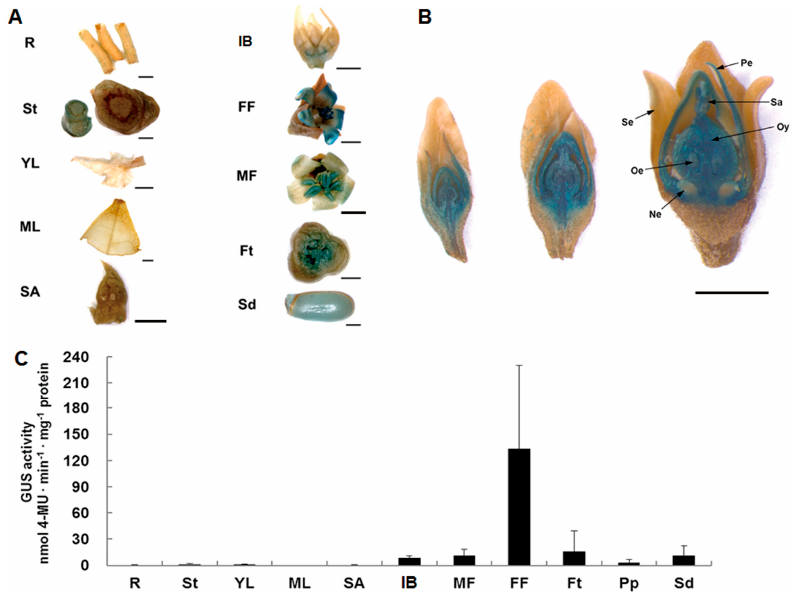
Figure 1. Analysis of the activity of the J. curcas orthologue of TOMATO MADS BOX GENE 6 ( JcTM6 ) promoter in transgenic J. curcas . ( A ) Histochemical β -glucuronidase (GUS) staining in various plant organs of adult transgenic J. curcas plants (T0). ( B ) Histochemical GUS staining in female flowers during development. ( C ) Fluorometric assay of GUS activity in adult transgenic J. curcas plants (T0). The values represent the means ± standard deviations ( n = 5). The GUS activities were measured three times. FF, female flowers; Ft, fruits at 12 days after pollination (DAP); IB, inflorescence buds; MF, male flowers; ML, mature leaves; Ne, nectaries; Oe, ovules; Oy, ovaries; Pe, petals; Pp, pericarps at 25 DAP; R, roots; SA, shoot apices; Sa, stigmas; Sd, seeds at 25 DAP; Se, sepals; St, stems; and YL, young leaves. Scale bars = 2 mm.